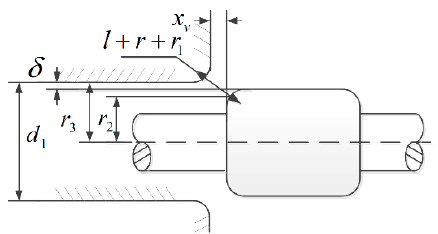
Figure 2. The orifice of servo valve after wear by solid particles.